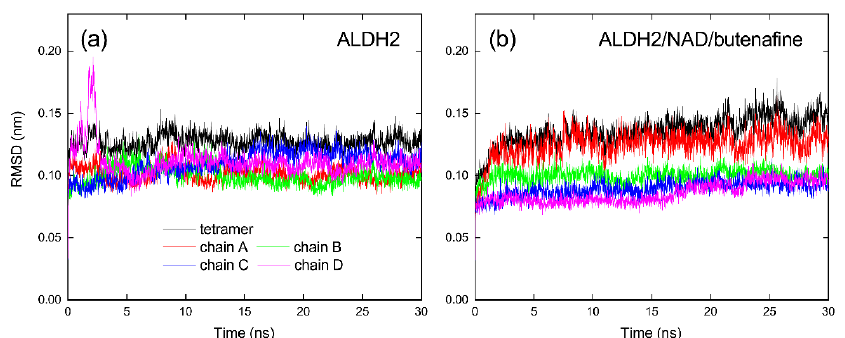
Figure 2. Root-mean-square deviation (RMSD) of protein backbone from crystal structure as a func- tion of simulation time for the ALDH2 tetramer and monomers (chains A–D) in the apo form ( a ) and in the complex form ( b ) with the co-factor NAD + and the inhibitor butenafine.